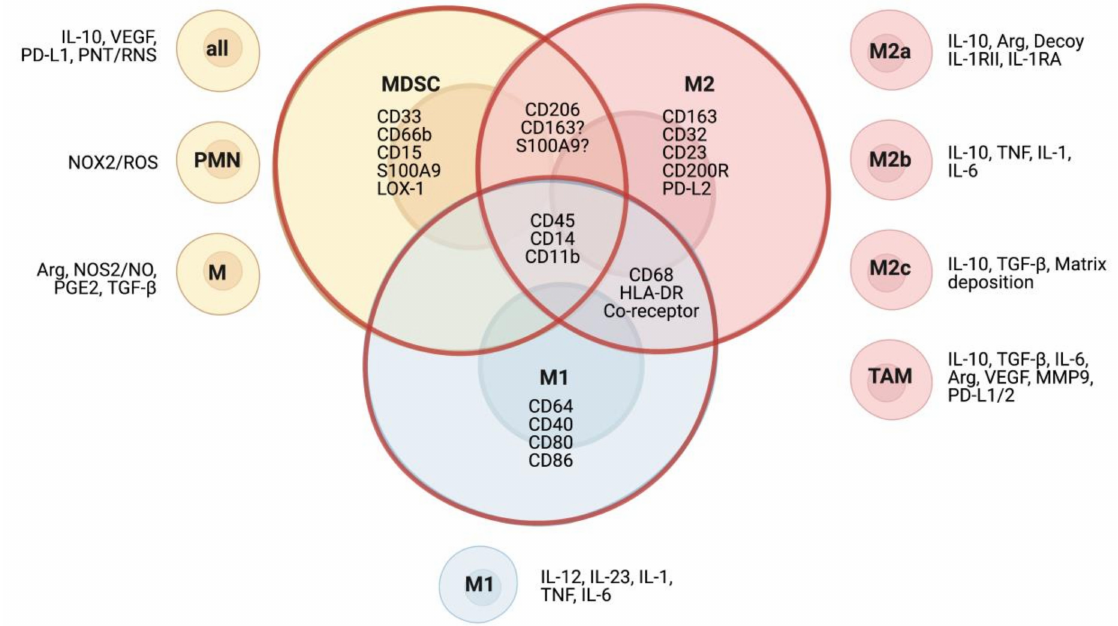
Figure 1. Phenotypic surface markers and functional subsets of myeloid cells in humans. Venn diagram shows typical cellular markers of MDSC, M1, and M2 macrophages. Markers shared between cell types are shown in overlapping areas of the